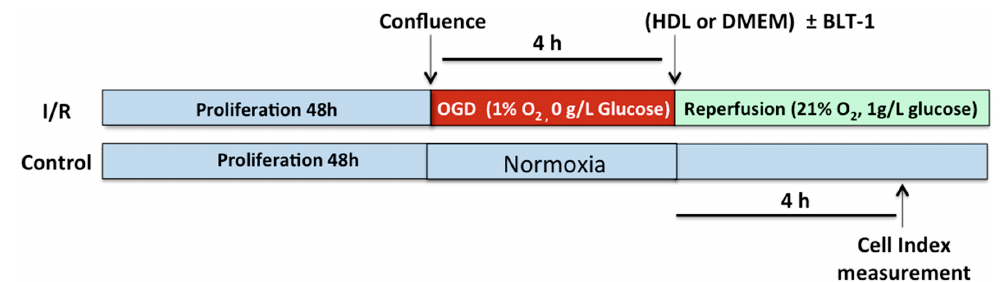
Figure 3. General scheme of experiments using a human cellular model of BBB in normoxia and ischemia/reperfusion conditions. hCMEC/D3 cells were grown in a 8-well L-plate (iCELLigence system) for 48 h to reach confluence. Cells were then subjected to normoxic or ischemia/reperfusion (I/R) conditions. I/R was mimicked by a 4h OGD followed by addition of 21% oxygen and 1g/L glucose. At reperfusion, hCMEC/D3 were incubated with HDLs or culture medium alone (DMEM) with or without increasing concentrations of SR-BI inhibitor, BLT-1. Cell impedance was monitored in real time using the RTCA Software during the whole experiment. At confluence, hCMEC/D3 were subjected to normoxia (Figure 4A) or to a 4-h oxy- gen-glucose deprivation (OGD) followed by reperfusion (Figure 4B) with or without HDL incubation. In normoxic conditions, incubation of hCMEC/D3 with HDLs for 4 h increased the cell index relative to saline (6.80 ± 0.08 vs. 5.91 ± 0.1, respectively, p < 0.0001) (Figure 4C). In ischemia/reperfusion conditions, OGD led to a decrease of cell index relative to baseline (4.54 ± 0.11 vs. 6.11 ± 0.11, respectively, p < 0.0001) (Figure 4C). HDL addition to hCMEC/D3 at reperfusion maintained the BBB integrity as compared to incubation with culture medium alone (5.99 ± 0.10 vs. 4.54 ± 0.11, respectively, p < 0.0001) (Figure 4C).